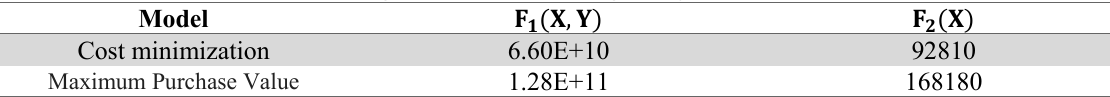
The maximum and minimum of target functions are single-objective